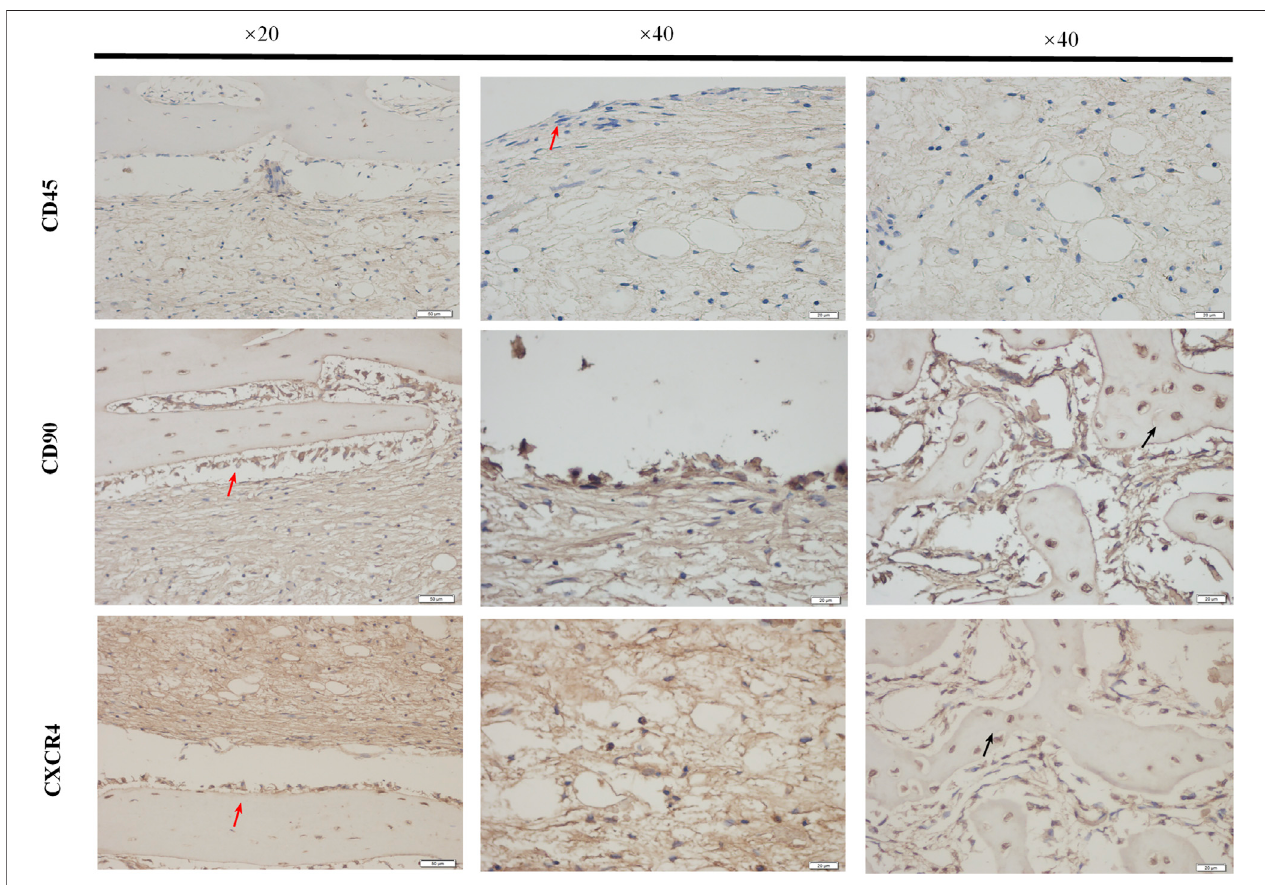
FIGURE 11 | The expressions of BMSCs markers. The paraf fi n sections of bone samples 21 days after the external cap implant grafted, and the expressions of BMSCsmarkers(CD45,CD90)chemokinesCXCR4weredetectedbyimmunohistochemicalstaining.Thebrown-yellowparticlesindicatedthepositiveexpression.The expression of CD45 was negative and that of CD90 was positive, while the expressions of BMSCs chemokines CXCR4 were also positively expressed.